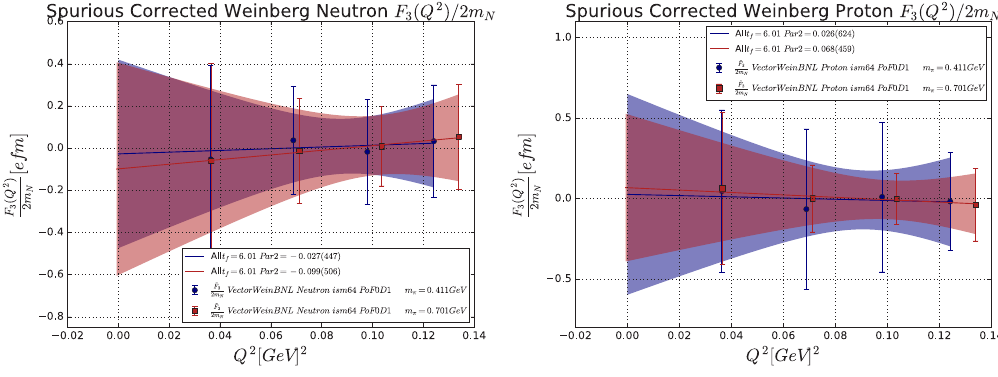
Figure 7. Corrections suggested by [21] CP-odd vector form factor F 3 / 2 m N in units of α W / Λ 2 for the neutron Figure 5. Flow time dependence from t f / a 2 = 4 . 01 (blue) to t f / a 2 = 8 . 01 (red) of the CP-odd vector form factor (left) and proton (right), induced via the Weinberg operator CP-violating vacuum, plotted against transfer mo- F 3 / 2 m N in units of α W / Λ 2 , induced via the Weinberg CP-violating vacuum, plotted against transfer momentum mentum Q 2 . Blue and red points are the m π = 411 , 701 MeV results respectively. The linear fit to Q 2 Q 2 . Left and right plots show the m π = 411 , 701 MeV results respectively. The linear fit to Q 2 0 is used to to extract the value for the neutron and proton EDM d n / p → extract the value for the neutron and proton EDM d n / p .